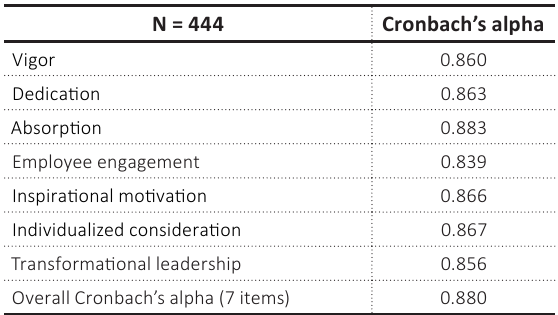
Table 2. Reliability statistics